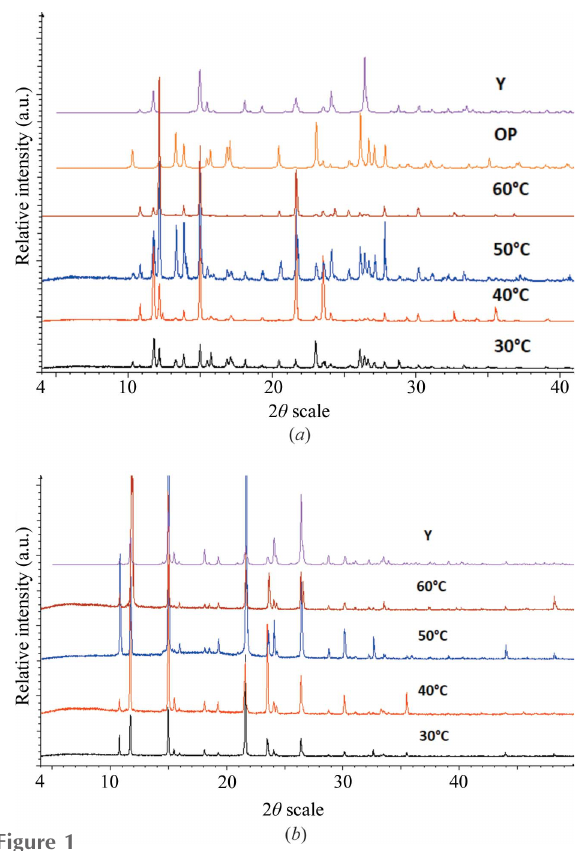
Figure 1 Powder diffractograms of the temperature screening of ( a ) ROY and ( b ) d 1 -ROY from 30 to 60 (cid:3) C (with slow cooling) and the reference diffractograms of OP and